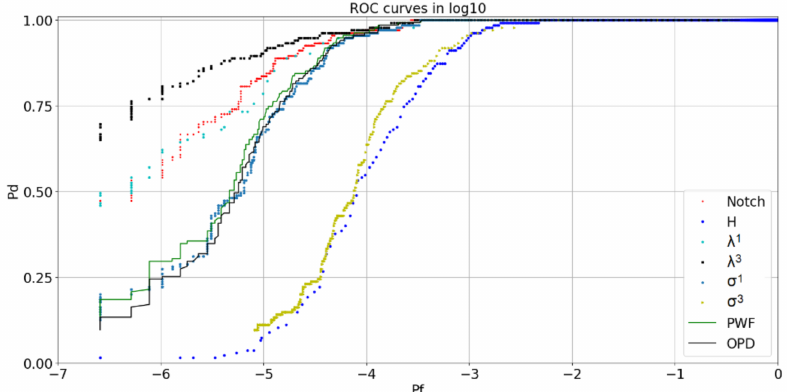
Figure 12. Iceberg detection ROC curves for sea ice, target window 5 × 5, clutter window 105 × 105. Notch means the polarimetric notch filter, H means entropy, λ 1 and λ 3 are the first and third eigen- values of the covariance matrix, σ 1 and σ 3 are from the polarimetric match filter, PWF means the polarimetric whitening filter, and OPD means the optimal polarimetric